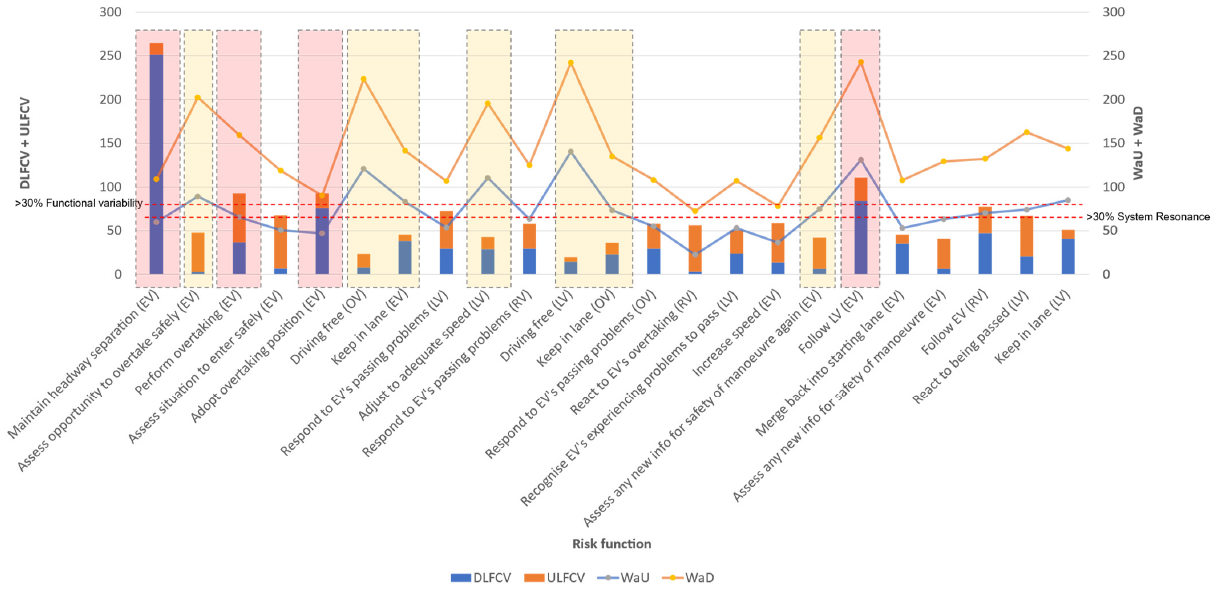
Figure 11. Risk functions for human drivers composed of functional variability and system resonance.